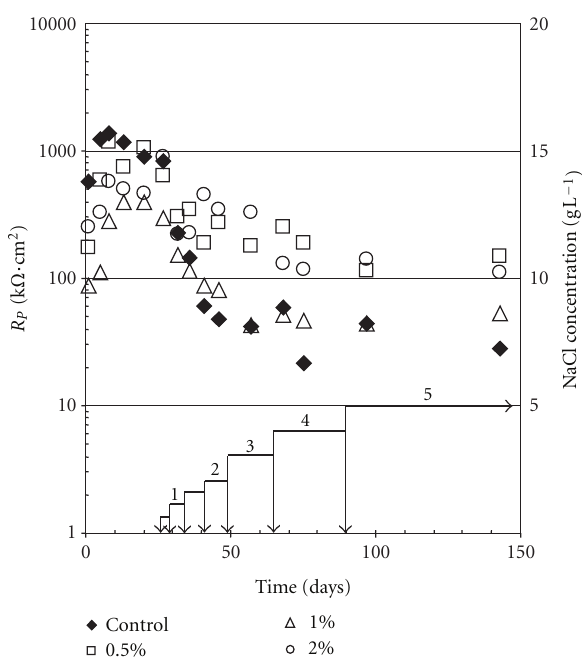
Figure 2: Average polarization resistance ( R P ) values for all SCH electrochemical cells evaluated [7].